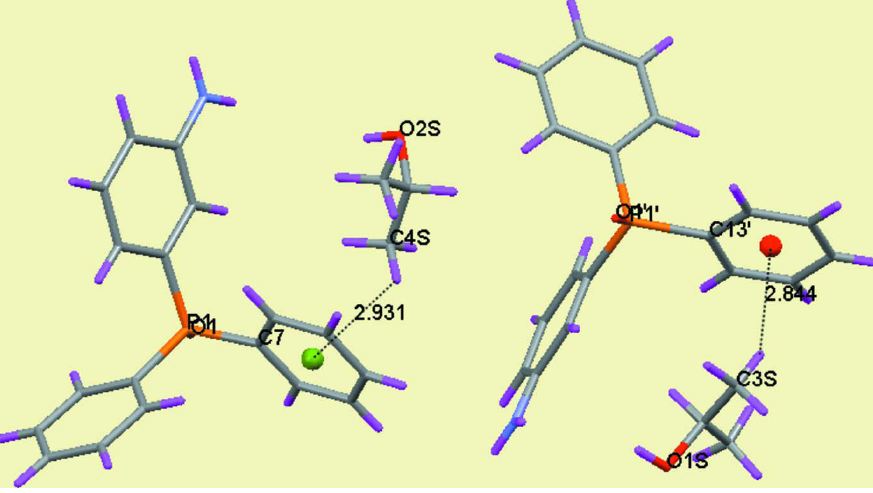
Figure 4 C—H··· π Stacking interactions between C–H group of 2-propanol molecules with aromatic phenyl rings. The H··· π distances (measured to the center of phenyl rings) is 2.84 Å for C3S—H3SC··· Cg 1 (1 - x , - y , 1 - z ) and 2.93 Å for